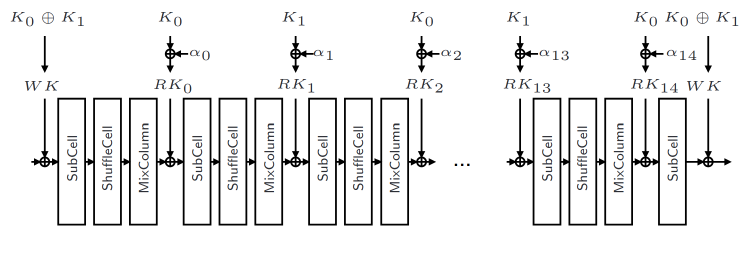
Figure 1: Overview of Midori-64 [BBI +